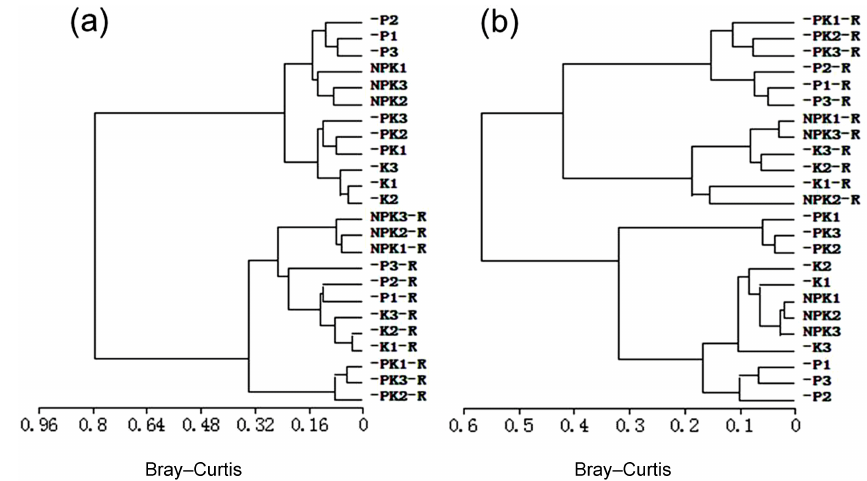
Figure 4. Cluster analysis of mcrA - (a) and pmoA -based (b) T-RFLP profiles from rice tillering stage. The letter “R” after the treatments indicates samples from the mRNA-derived profile. NPK: balance chemical fertilisation; − K: potassium deficient; − P: phosphorus deficient; − PK: phosphorus and potassium deficient. Table 2. Correlation between CH 4 flux and methanogenic and methanotrophic populations and soil